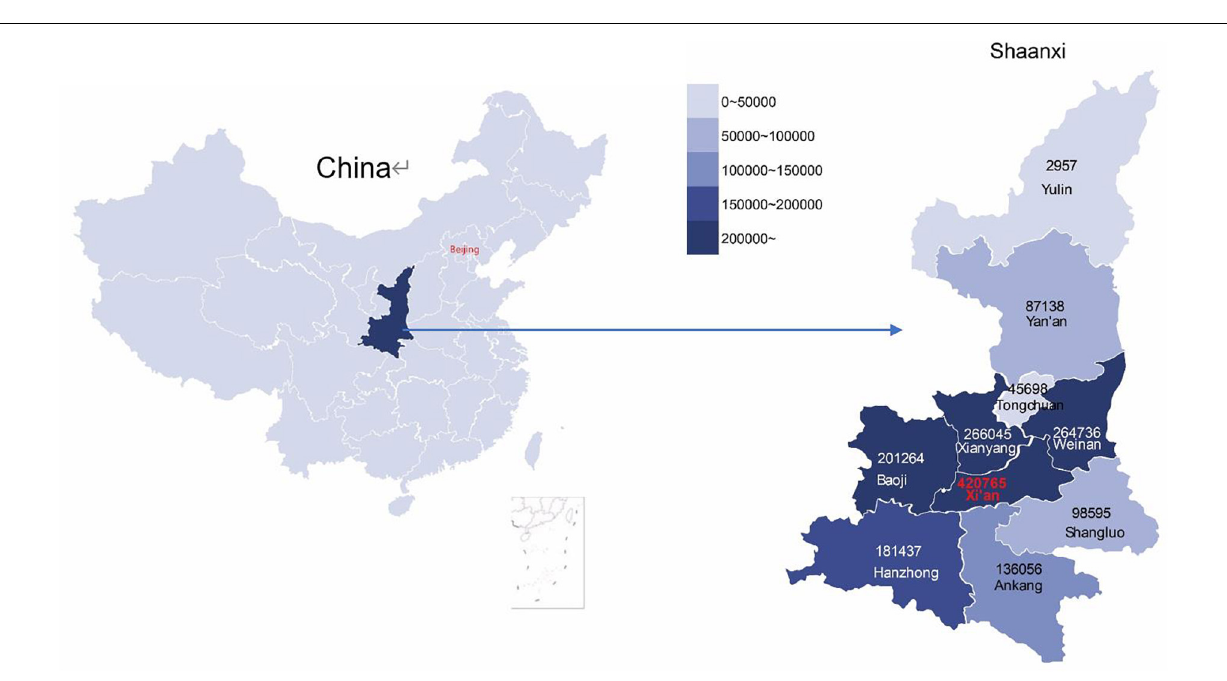
FIGURE 2 | The geographical distribution of enrolled blood donors in the cohort in Shaanxi province, China. The enrolled non-blood donors share an identical